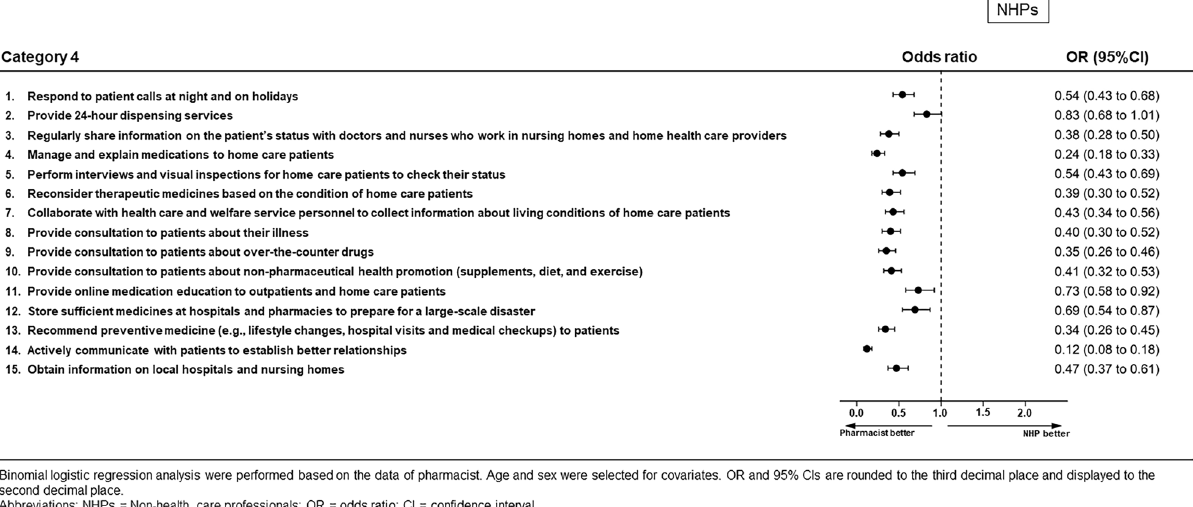
Figure 7. Results of binomial logistic regression analysis for Category 4 for non-health care professionals.